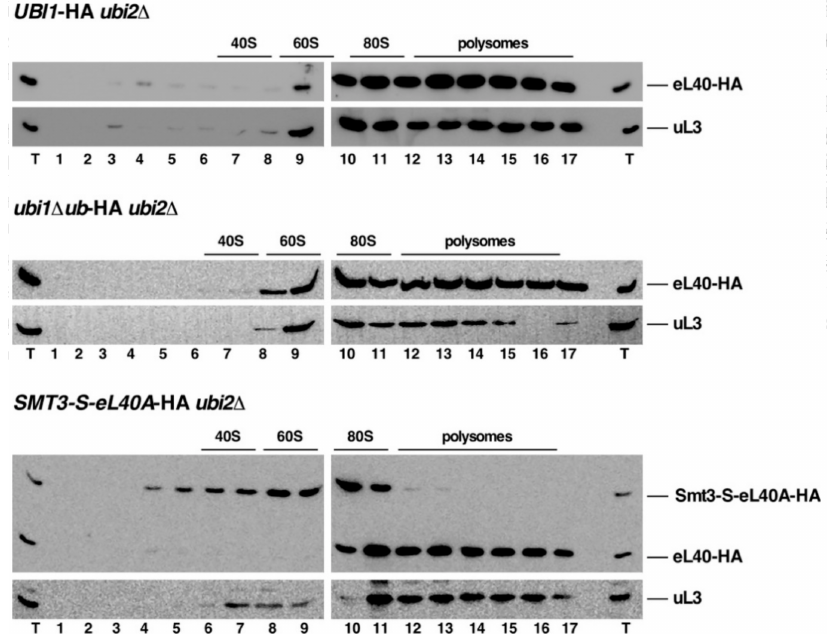
Figure 6. Incorporation of eL40A-HA, derived from the Ubi1-HA, Ubi1 ∆ ub-HA, and Smt3-S-eL40A-HA precursors, into translating ribosomes. Strains SMY256 ( UBI1 -HA ubi2 ∆ ), SMY257 ( ubi1 ∆ ub -HA ubi2 ∆ ), and SMY258 ( SMT3-S-eL40A -HA ubi2 ∆ ) were grown in YPD medium at 30 ◦ C to mid-log phase. Cell extracts were prepared and 10 A 260 units of each extract were resolved in 7–50% sucrose gradients. Fractions were collected from the gradients, the proteins were extracted from each fraction, and equal volumes were analyzed by western blotting using anti-HA and anti-uL3 antibodies. The position of free 40S and 60S r-subunits, vacant 80S ribosomes / monosomes, and polysomes, obtained from the recorded A 254 profiles, are shown. T, total cell